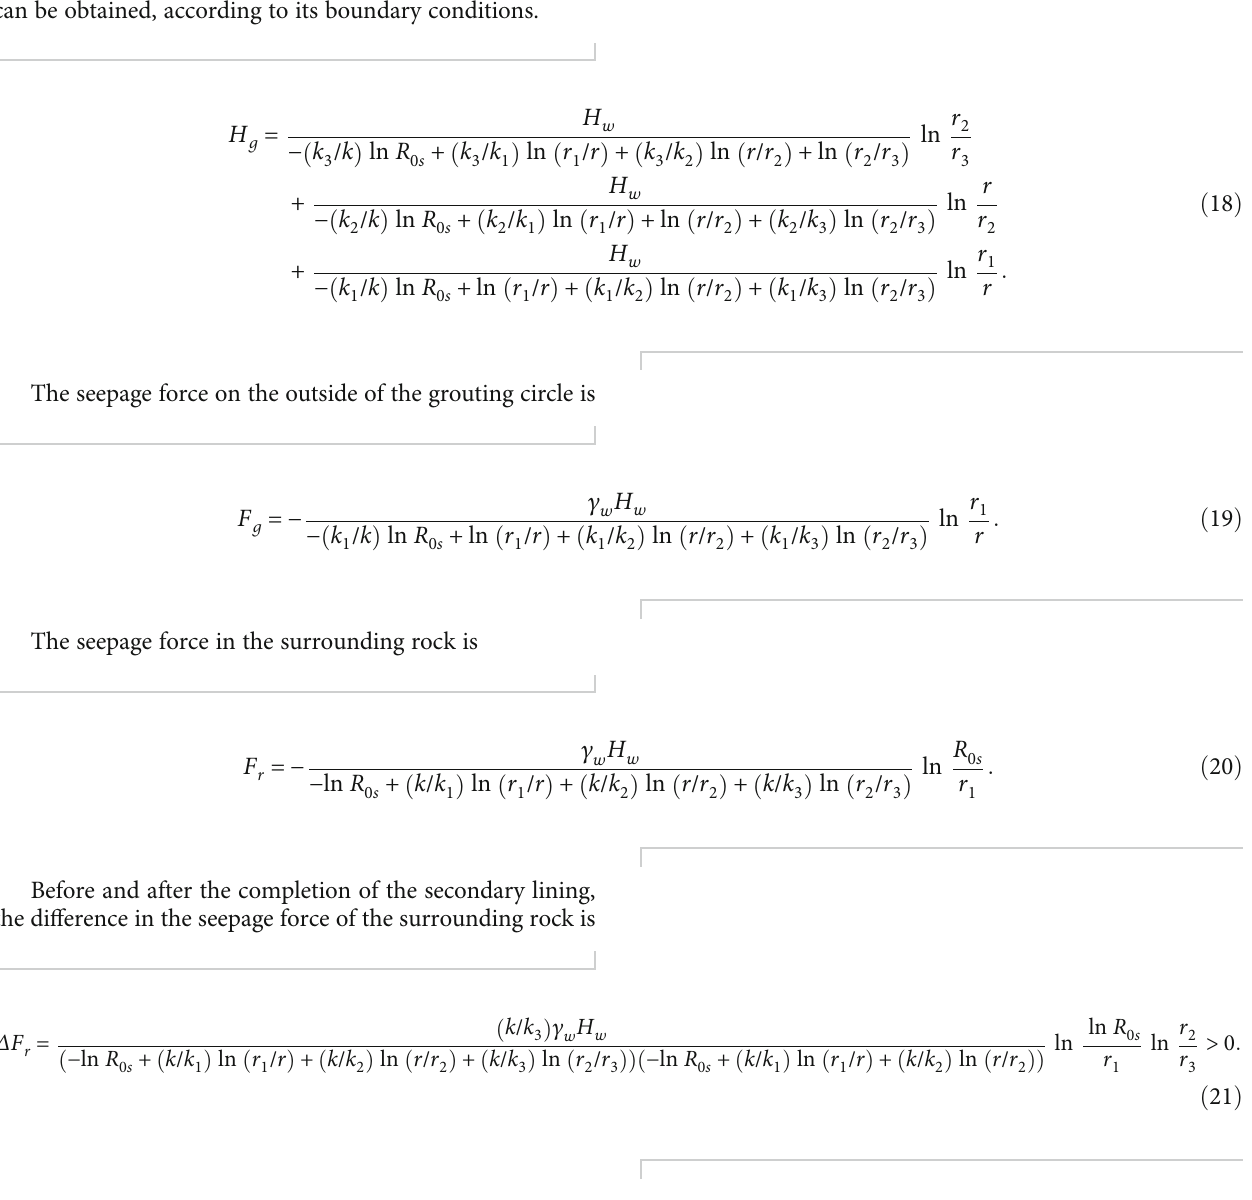
= 5 : 5 m , the numerical simulation tunnel 16 : 5 m , and r w model consists of 186240 elements, as shown in Figure